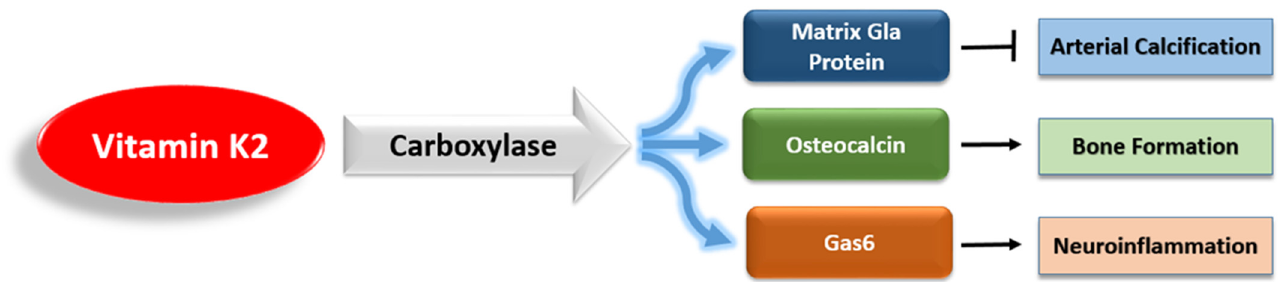
Figure 3. The main vitamin K-dependent proteins that are activated by vitamin K2. VK2 also acts as a transcriptional regulator and has antioxidant properties [41–43]. Unlike VK1, VK2 possesses immunosuppressant effects and inhibits T-cell proliferation